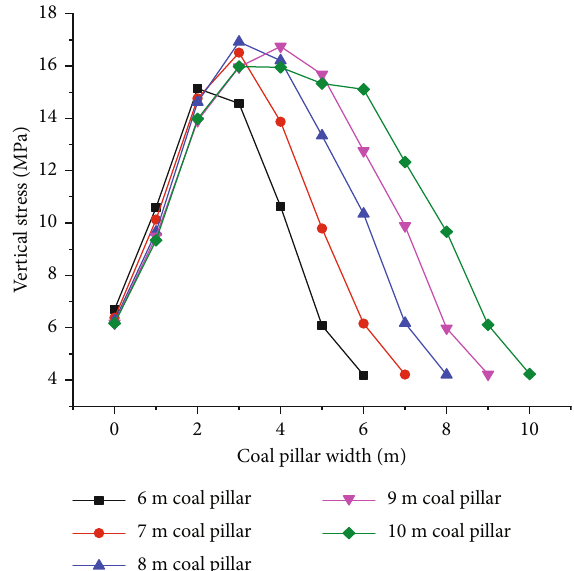
Figure 4: Vertical stress distribution law of coal pillars with di ff erent widths when the workface was advanced